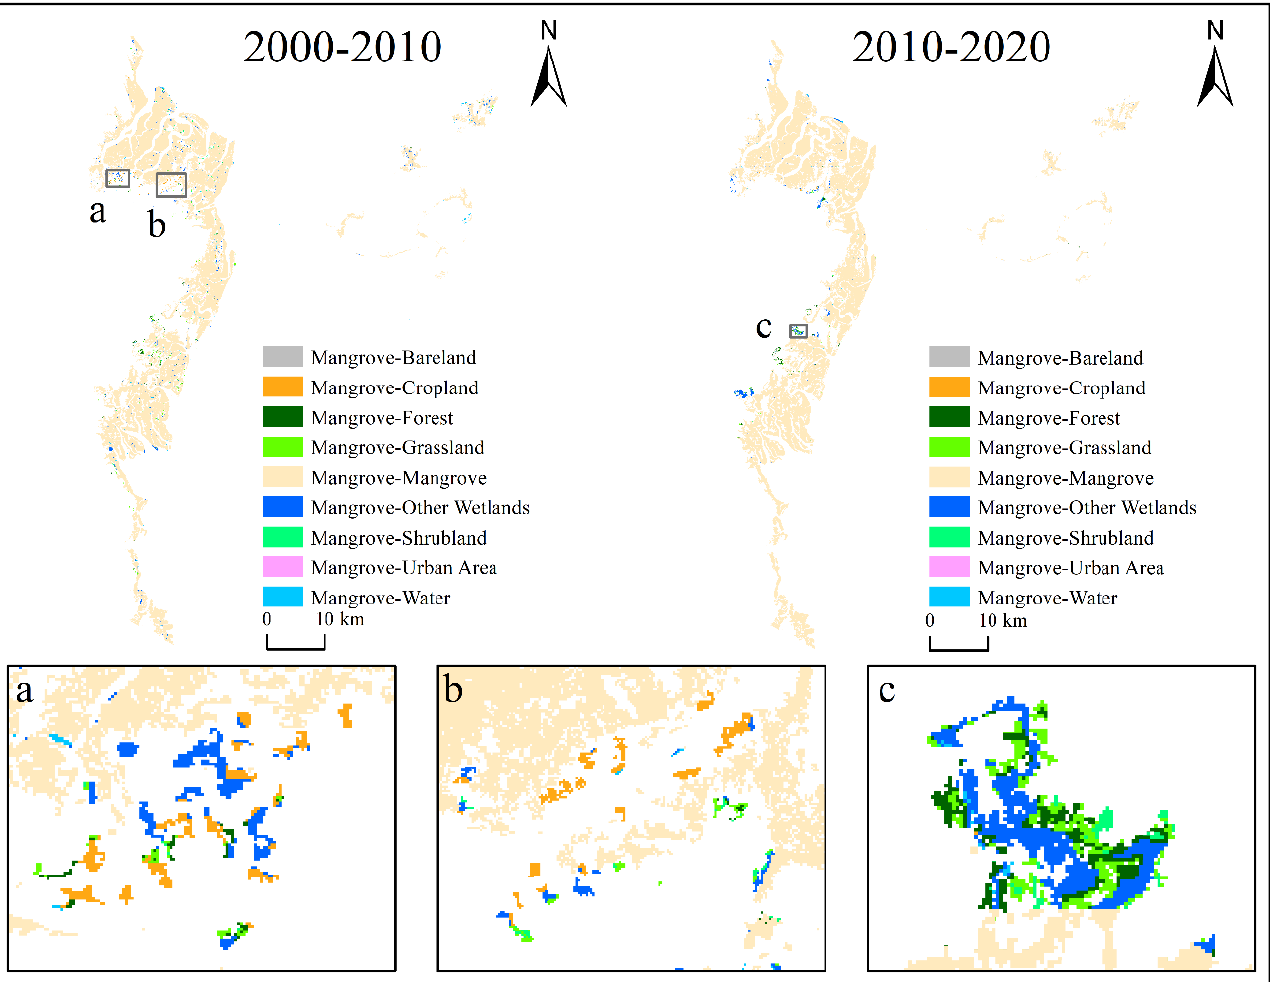
Figure 14. Maps of spatial–temporal distribution of mangrove degradation in RUMAKI from 2000 to 2020. ( a ) first degradation detail picture; ( b ) second degradation detail picture; ( c ) third degradation detail picture.